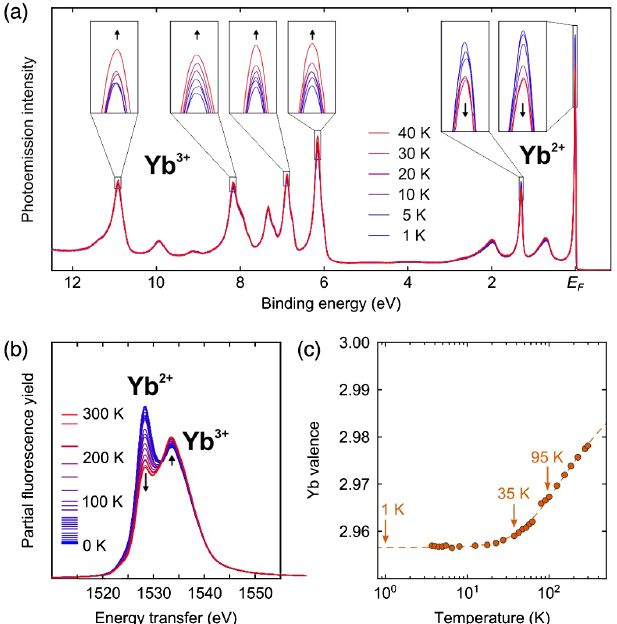
FIG. 1. Temperature dependence of the Yb valence in YbRh 2 Si 2 . (a) Angle-integrated photoemission intensity taken with high 4 f sensitivity at 110 eV photon energy. There is a clear shift of weight from Yb 2 þ to Yb 3 þ with rising temperature, consistent with the single impurity Anderson model. (b) Yb L α 1 RXES spectra from low to room temperature. A similar shift as in 4 f photoemission from Yb 2 þ to Yb 3 þ is seen. The temperature- dependent Yb valence obtained from the L α 1 spectra is shown on the right together with the best fit obtained within the noncrossing approximation to the Anderson impurity